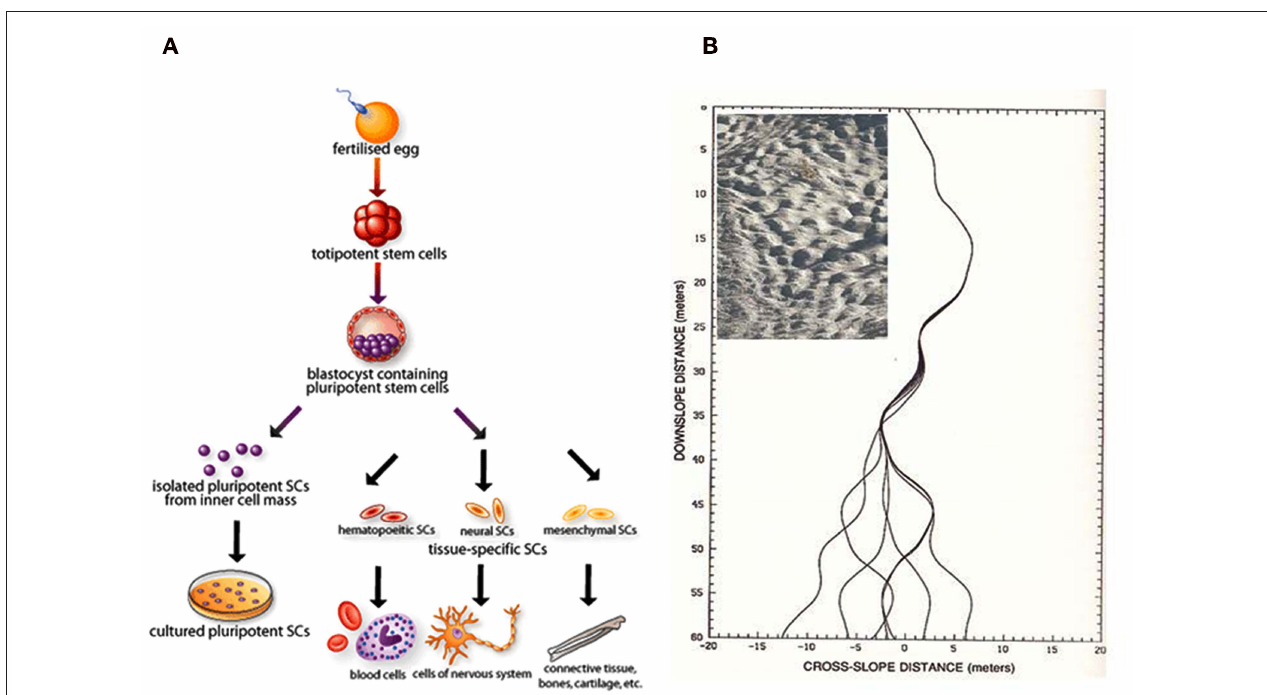
Figure 1 | Cell differentiation can be seen as a deterministic chaotic process. (A) Schematic of mammalian cell differentiation process, obtained from Chaudry (2004). (B) Diverging endpoints of seven boarders’ trajectories with minute (1 mm) changes in course maneuver at a ski slope with moguls (insert), adapted from